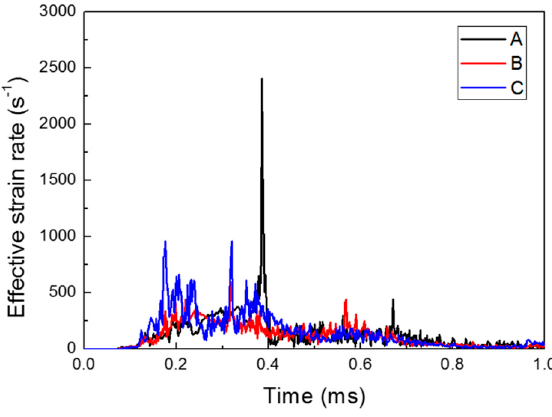
Figure 8. E ff ective strain rate of the deformed sheet Figure 8. Effective strain rate of the deformed sheet metal. Figure 8. Effective strain rate of the deformed sheet metal.